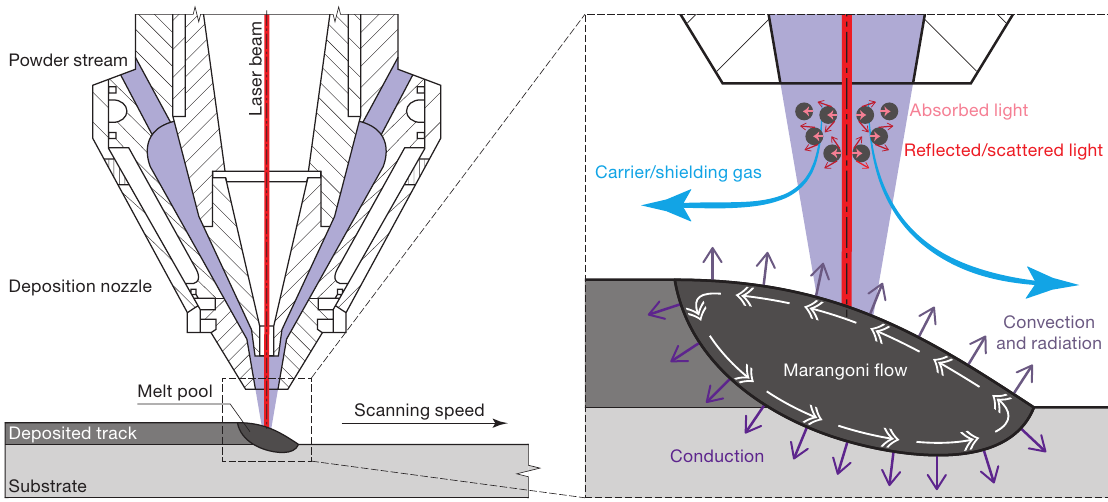
Figure 2. Schematic representation of the main phenomena involved in the LP-DED